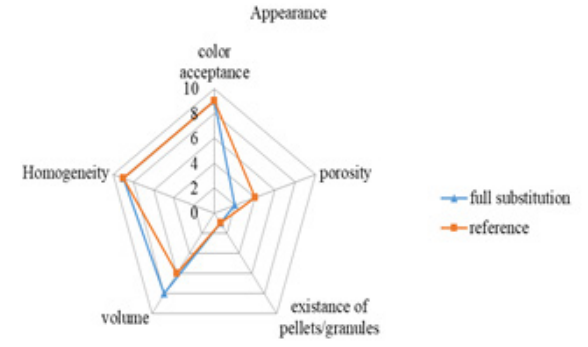
Figure 7: The results of the hedonic test about the appearance